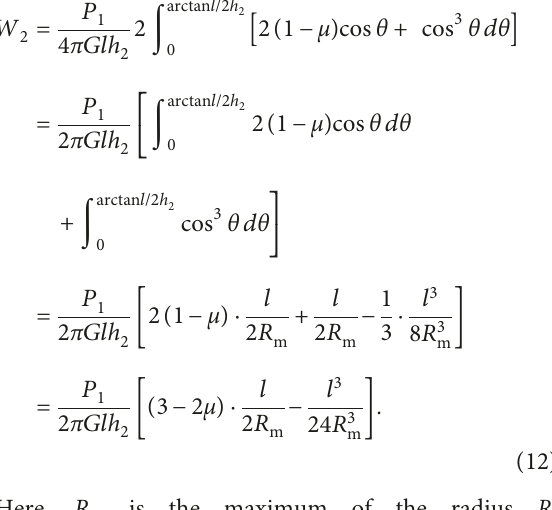
Figure 16: Sketch of the effect of uniform